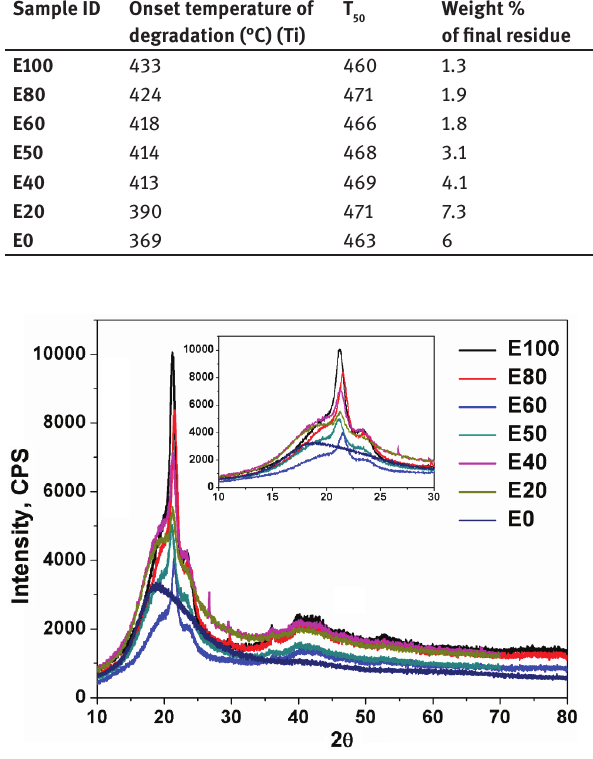
Figure 6: X-ray diffraction patterns of pristine EMA, NBR, and their various blends.